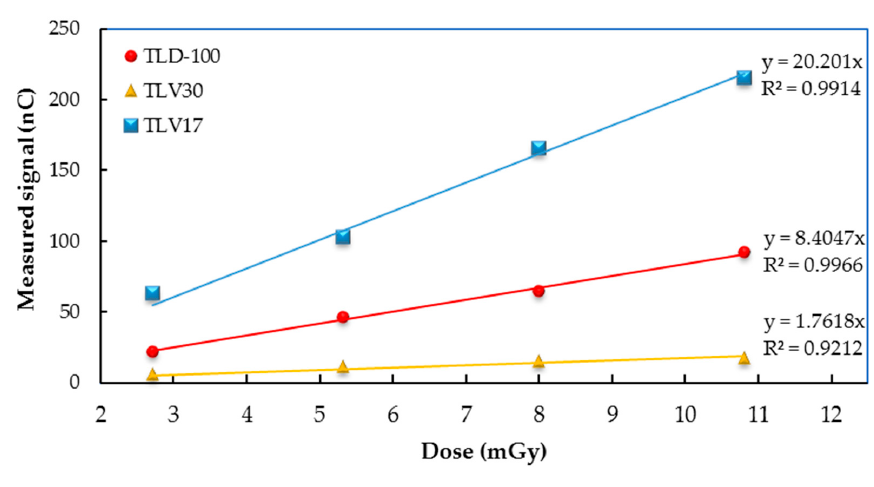
Figure 9. TLV17, TLV30 and TLD-100 radition dose–response linearity results from mammography.